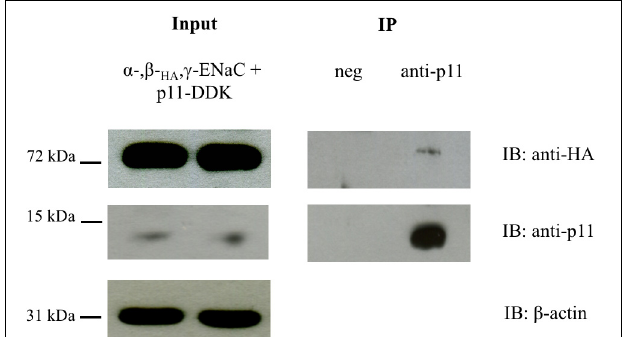
FIGURE 2 | p11 co-immunoprecipitates with ENaC. HEK293 cells were transfected with p11-myc-DDK and αβ HA γ ENaC. After 24 h, cells were lysed and immunoprecipitated with anti-p11 (ab89438) and protein G-agarose beads. Precipitates were analyzed by SDS-PAGE and immunoblotted (IB) with anti-HA to detect β HA ENaC (Mr ∼ 72 kDa) and p11 (Mr ∼ 11 kDa). ENaC was co-immunoprecipitated in the presence of anti-p11 but not when an unrelated antibody was used. Data shown are representative of three independent experiments with similar